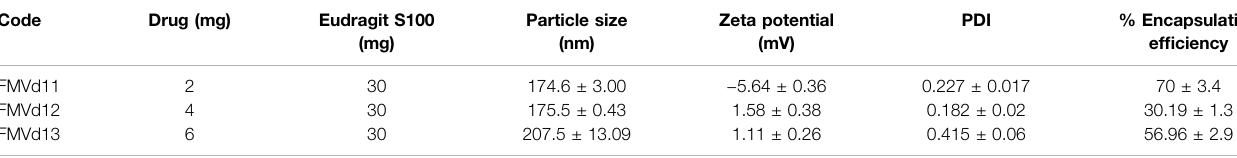
TABLE 4 | Effect Drug concentration on particle size and encapsulation ef fi